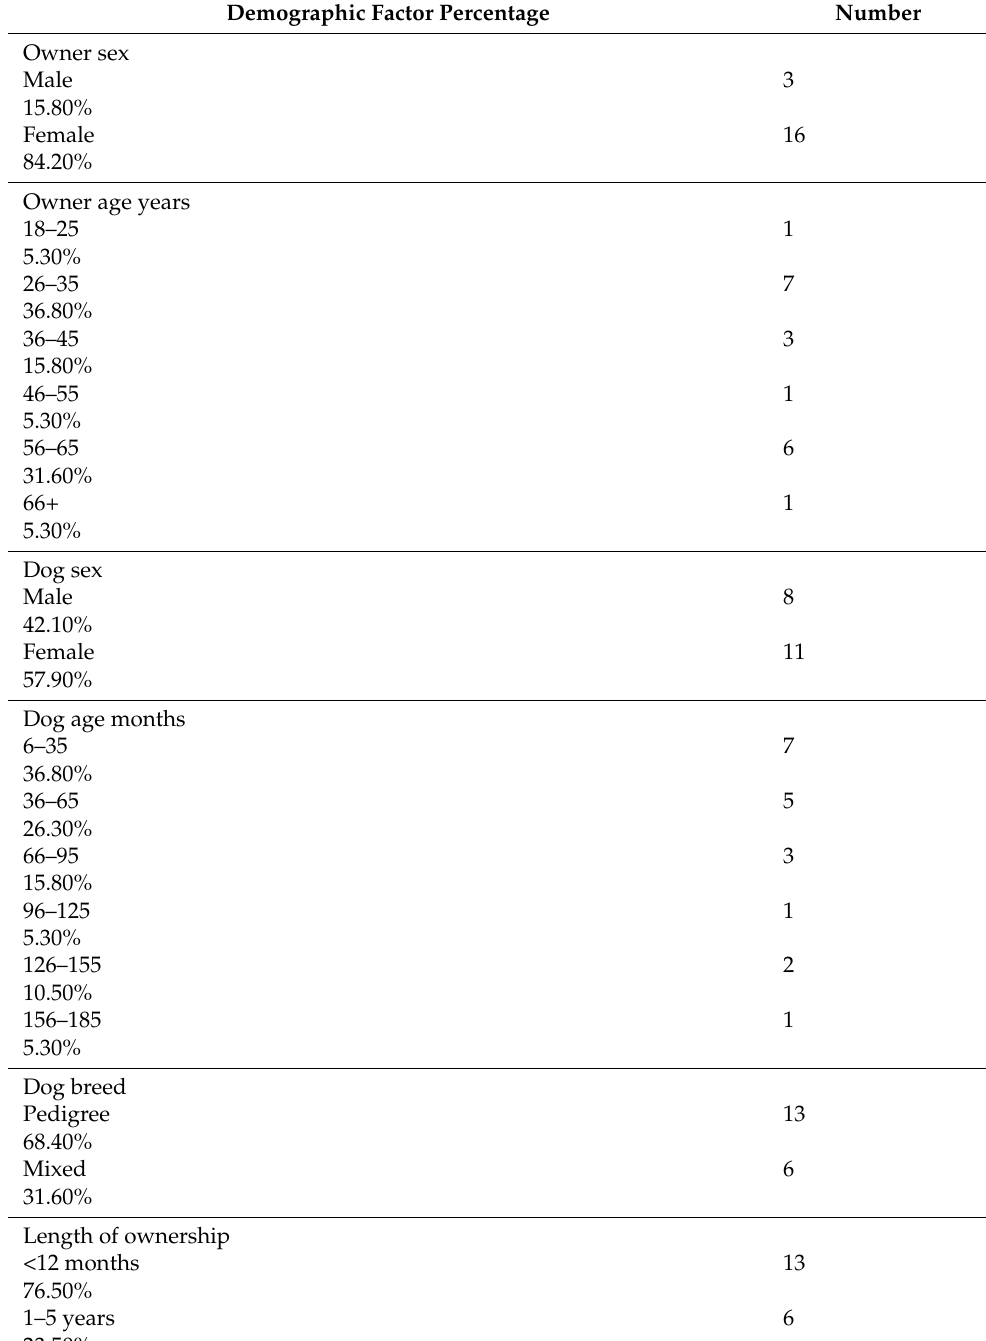
Table 1. Owner and dog